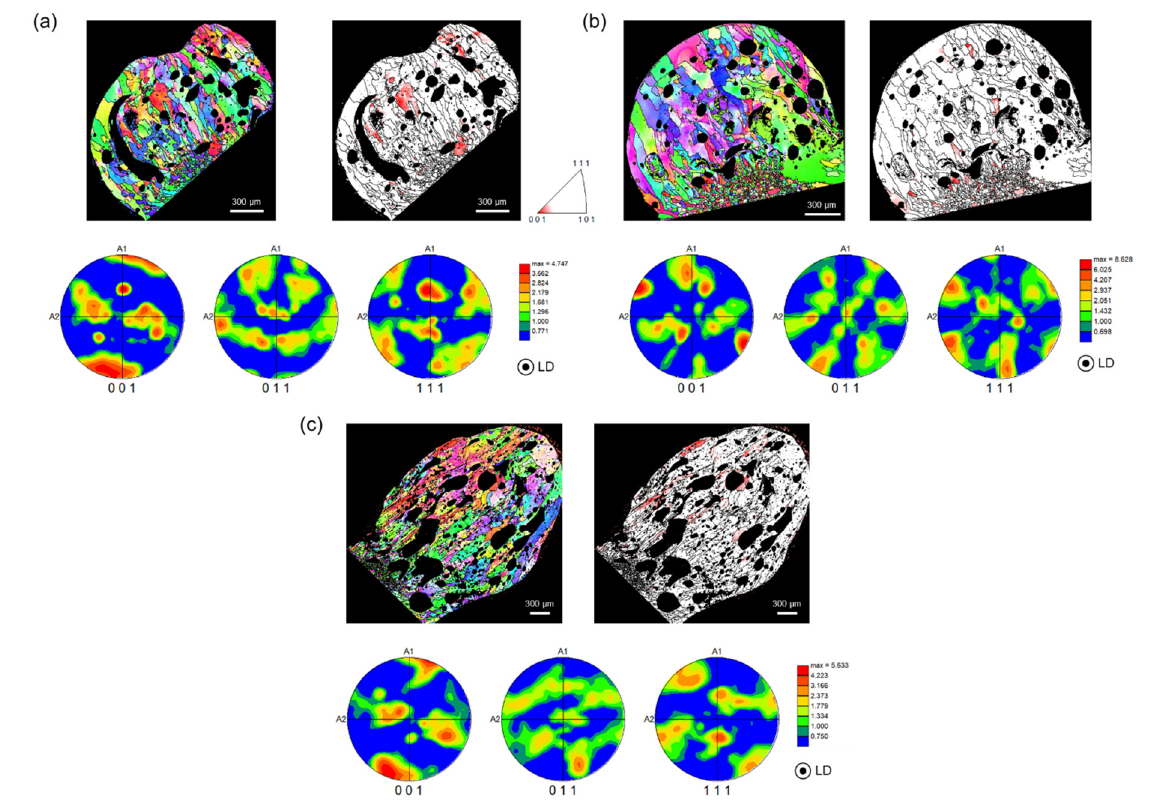
Figure 5. ( a ) Longitudinal direction (LD) orientation maps, ( b ) crystal direction maps of (001)//LD, and ( c ) pole figures of the SABs of three representative specimens.